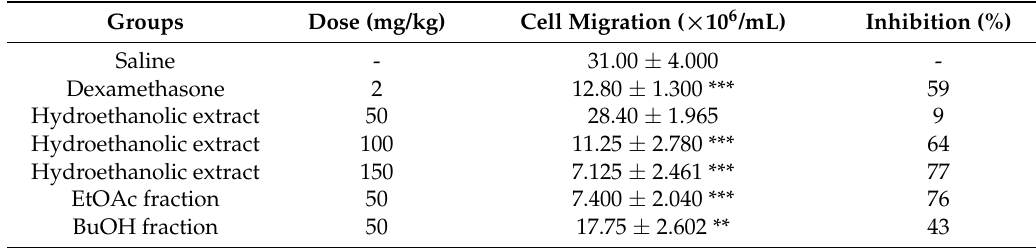
Table 2. Anti-inflammatory activity of the hydroethanolic extract and the ethyl acetate (EtOAc) and n -butanol (BuOH) fractions of T. catharinensis leaves in the zymosan-induced air pouch